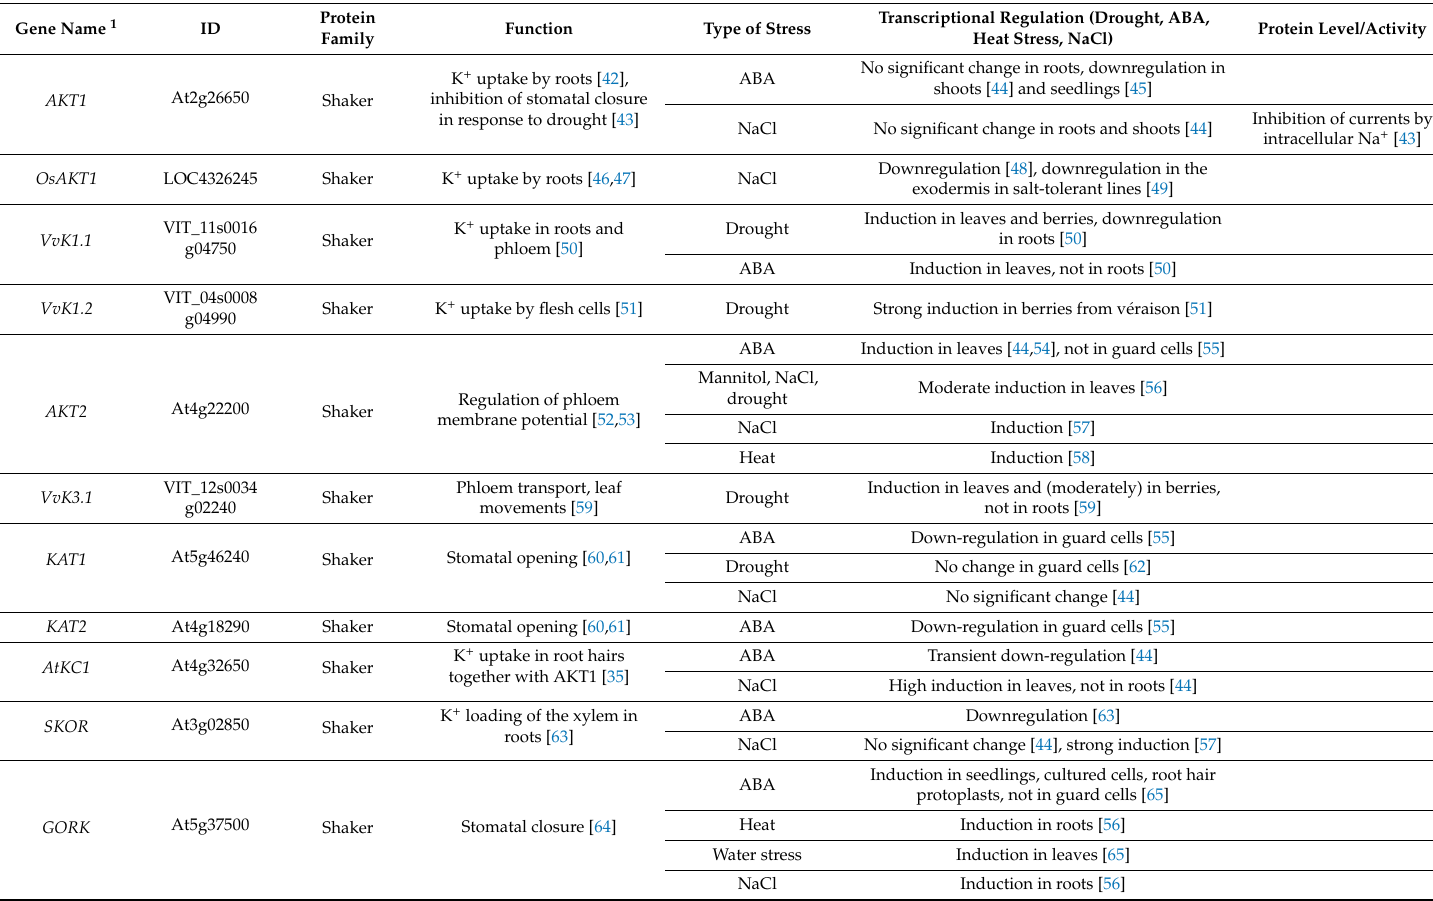
Table 1. Plant K + transport systems described in this study and their regulations in response to ionic and osmotic